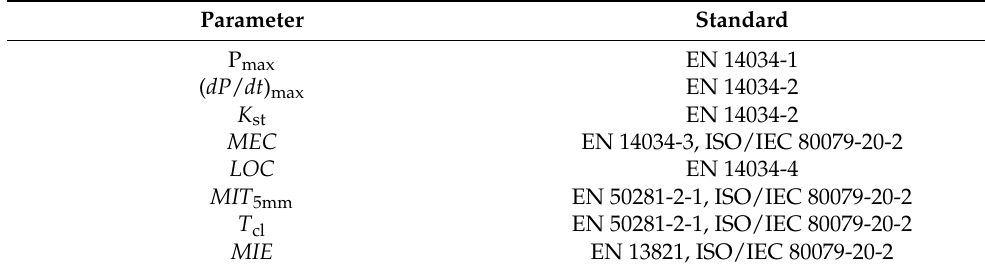
Table 4. Standard procedure used in the study.